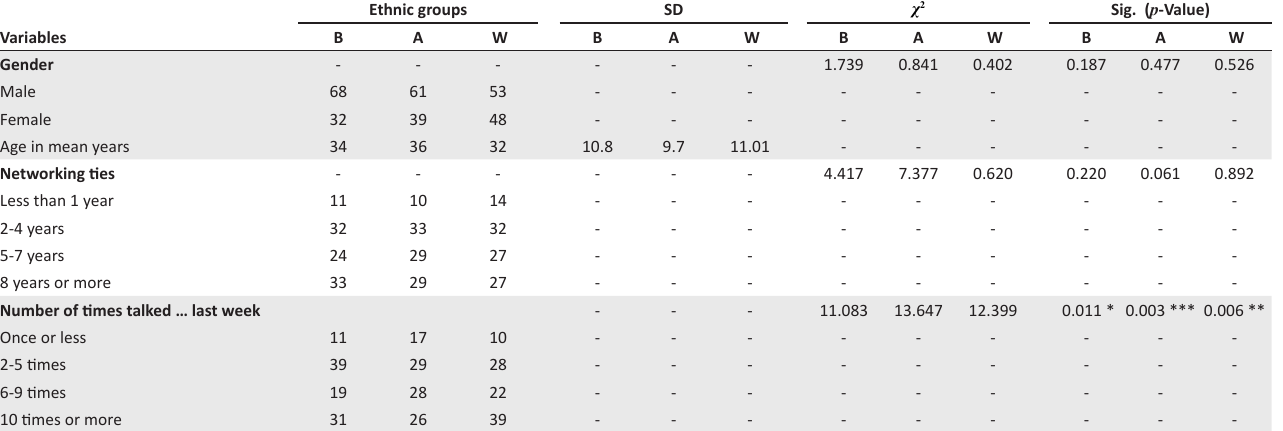
TABLE 1: Characteristics and differences in networking relationships and ties between ethnic groups. Ethnic